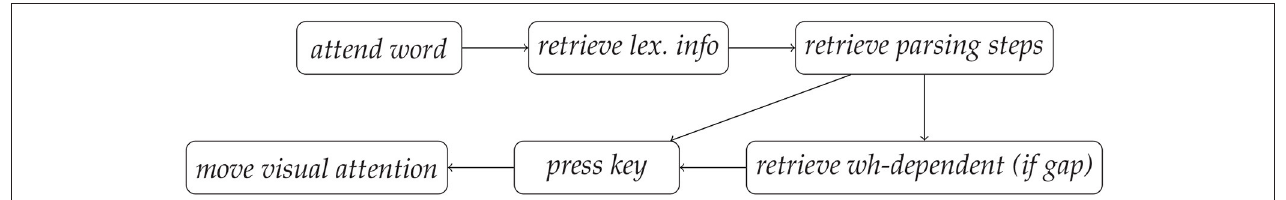
FIGURE 3 | Sequential model of reading on one word. Each box represents one process. Arrows show the order in which the processes fire. There are two arrows from retrieve parsing steps because retrieve wh-dependent is only triggered when a gap is postulated by the parser.